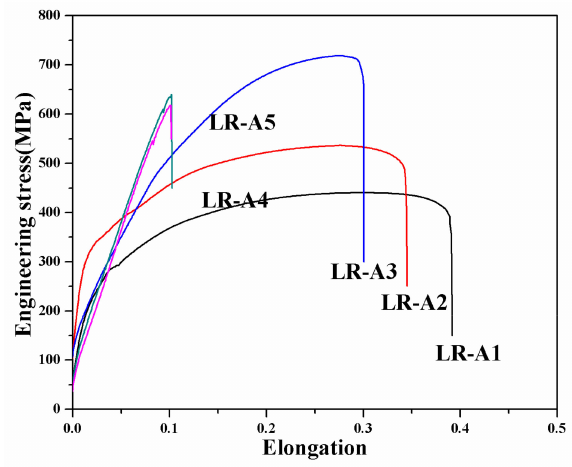
Figure 11. Comparative tensile curves of di ff erent bionic samples.